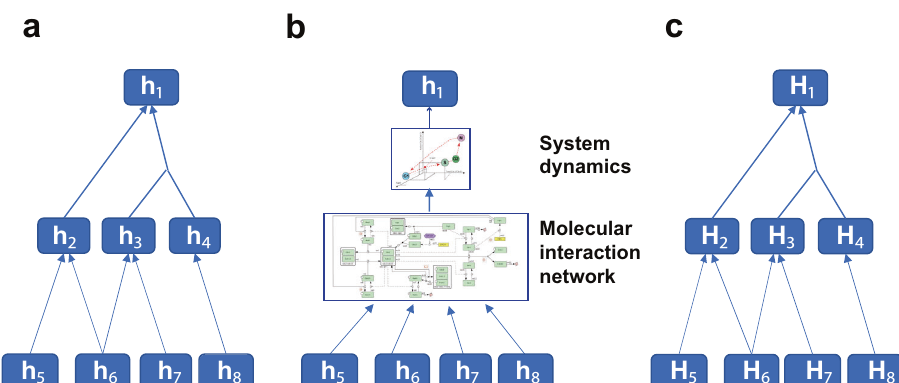
Fig. 4 Hypothesis dependency tree. a Each hypothesis is dependent upon other hypotheses that are related to molecular mechanisms. b A hypothesis in question can be veri fi ed only at the system-level analysis of molecular interaction network behaviors, c a set of hypotheses and their dependency tree where each element is also a set (e.g., H 1 ¼ h 0